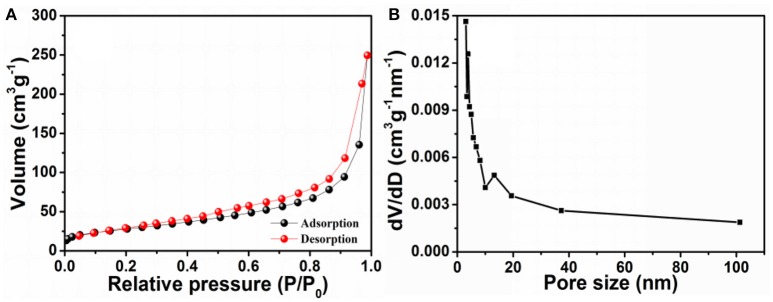
(A) N2 adsorption-desorption isotherm and (B) pore-size distribution curve of NaTi2(PO4)3/C.